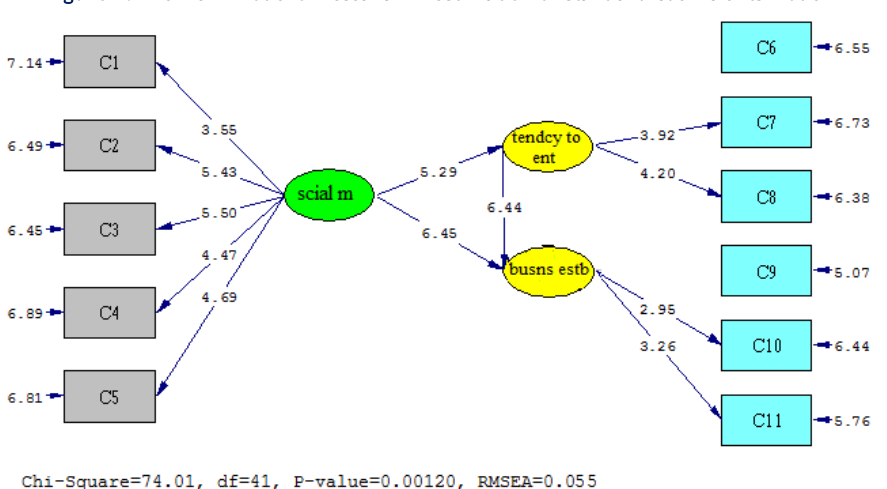
Figure 2. The main model of research in estimation of standard coefficients mode